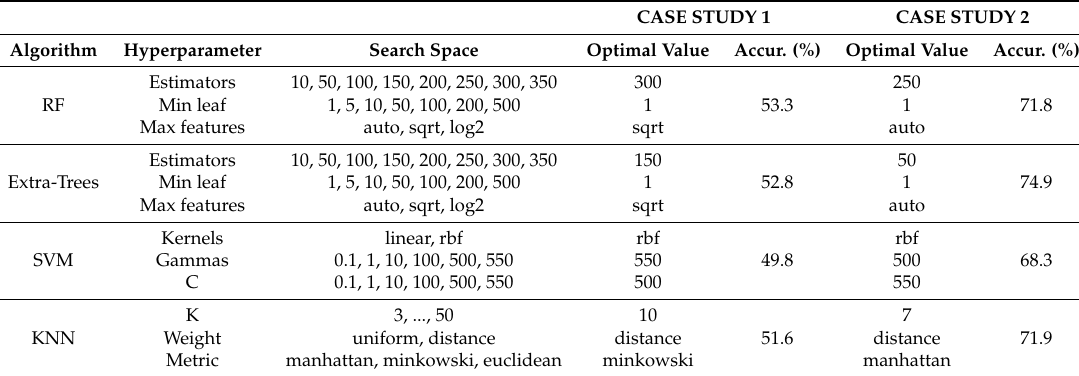
Table 7. Comparison of ML algorithms excluding weather features.